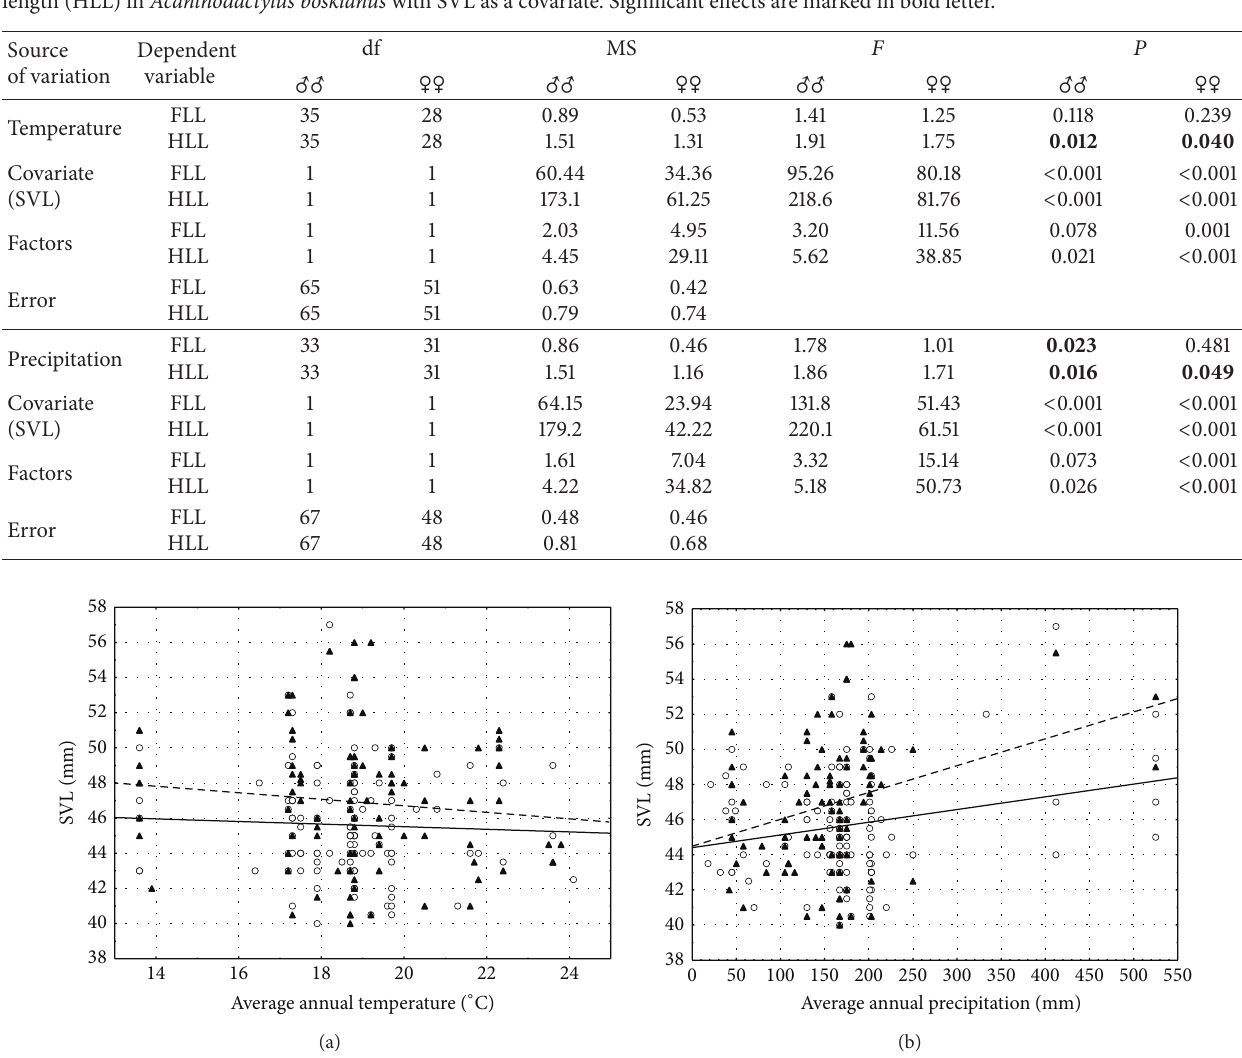
Figure 5: The relationship between SVL and (a) average annual temperature and (b) average annual precipitation in Mesalina guttulata : solid line with circles: males; dashed line with triangles: